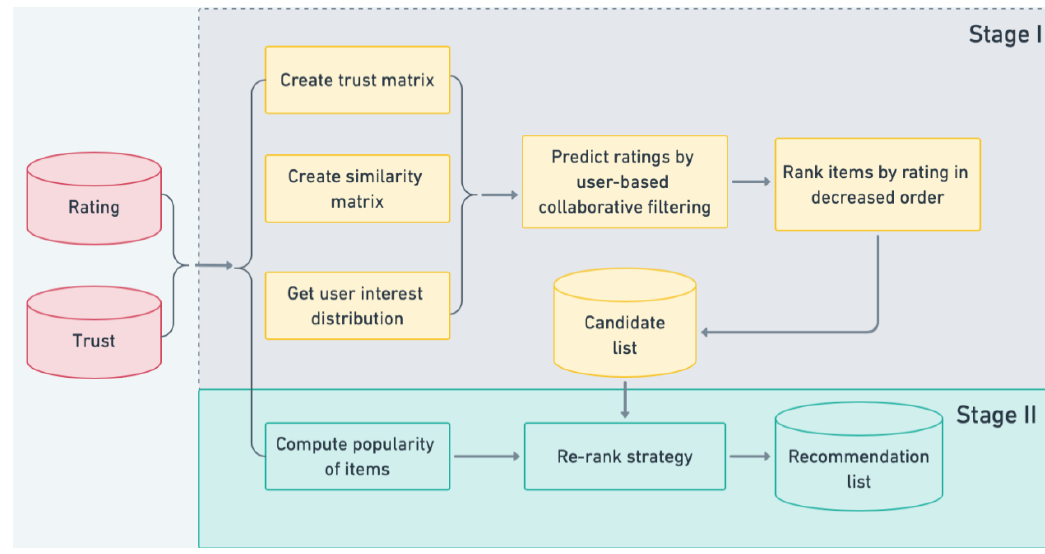
Figure 1. Overview of the main stages of the proposed method.